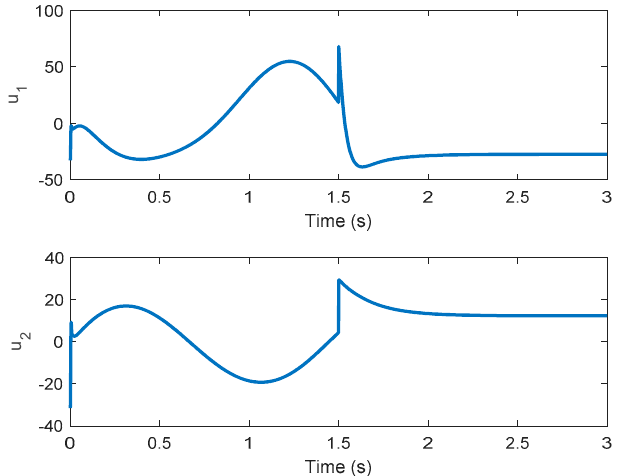
Figure8. Trackingerrorsoftheclosed-loopsystemwiththeflexiblePIDcontrollerandunknownperturbation. Figure 8. Tracking errors of the closed-loop system with the flexible PID controller and unknown